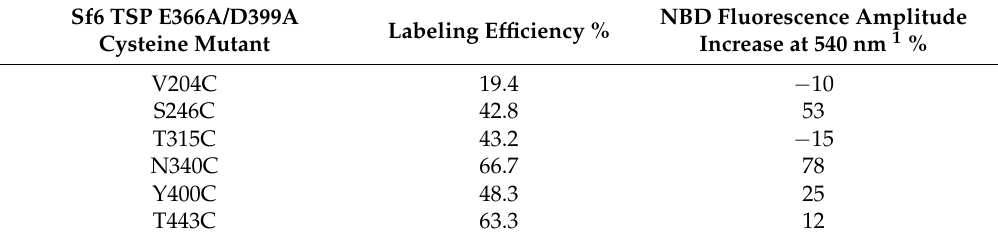
Table 2. N -methyl- N -[2-[methyl(7-nitro-2,1,3-benzoxadiazol-4-yl)amino]ethyl] (NBD)-fluorescent labelling of Sf6TSP E366A/D399A via cysteine